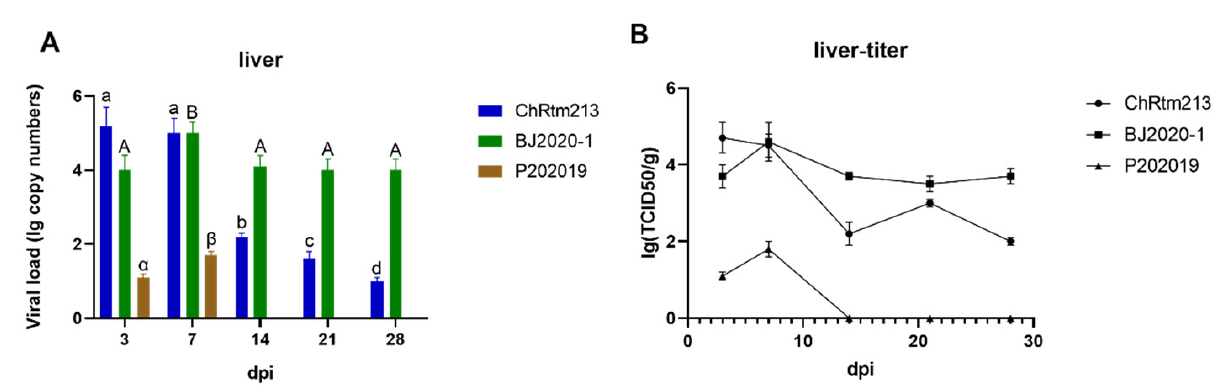
Figure 6. IPNV virus loads in the liver were sampled on 3, 7, 14, 21, and 28 dpi. ( A ) Replication kinetics of IPNV-infected rainbow trout. Samples were obtained in triplicate. Total RNA was extracted and analyzed by qPCR. Error bars represent the SD from triplicate within an experiment. Different letters of the same class indicated the statistical significance, p < 0.05. a, b, c, d indicated that the viral load of IPNV-ChRtm213 was significantly different at different sampling time points, p < 0.05. A, B indicated that the viral load of IPNV-BJ2020-1 was significantly different at different sampling time points, p < 0.05. α , β indicated that the viral load of IPNV-P202019 was significantly different at different sampling time points, p < 0.05. ( B ) The detection of viral titers in the liver of IPNV-infected rainbow